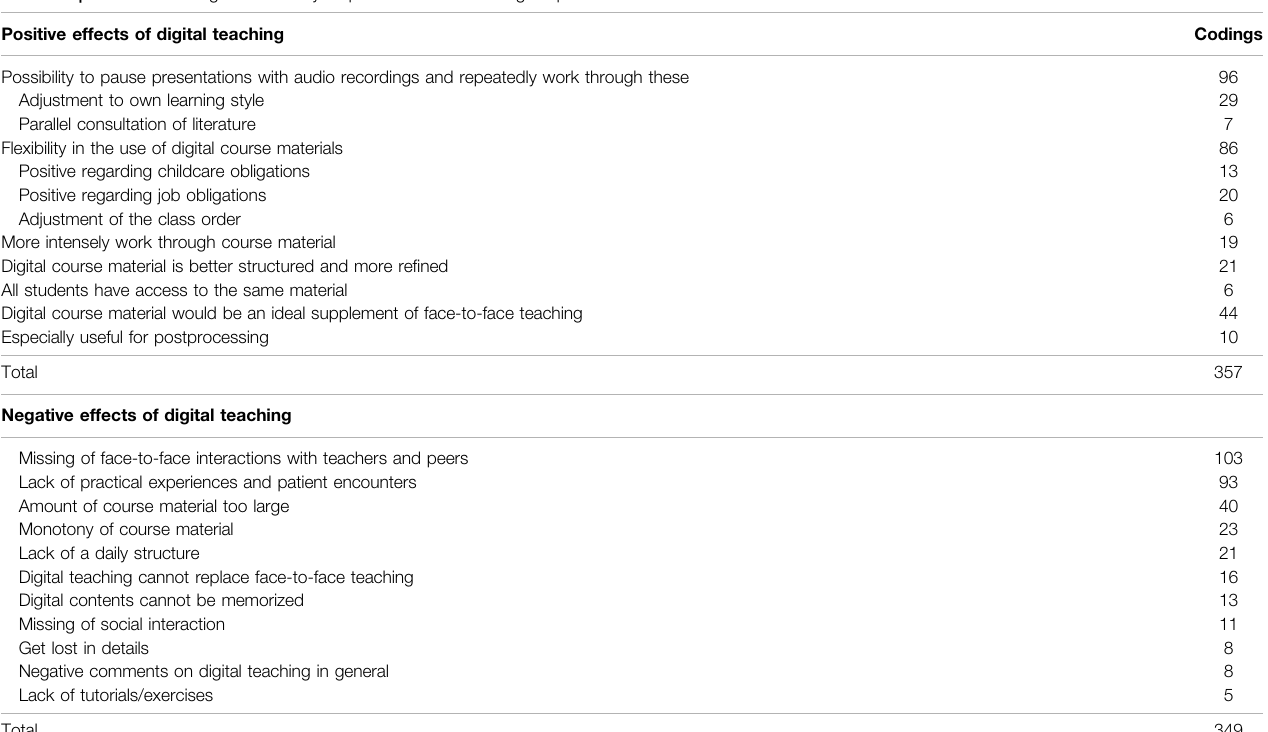
TABLE 2 | Codes and categories of study 1 qualitative data including